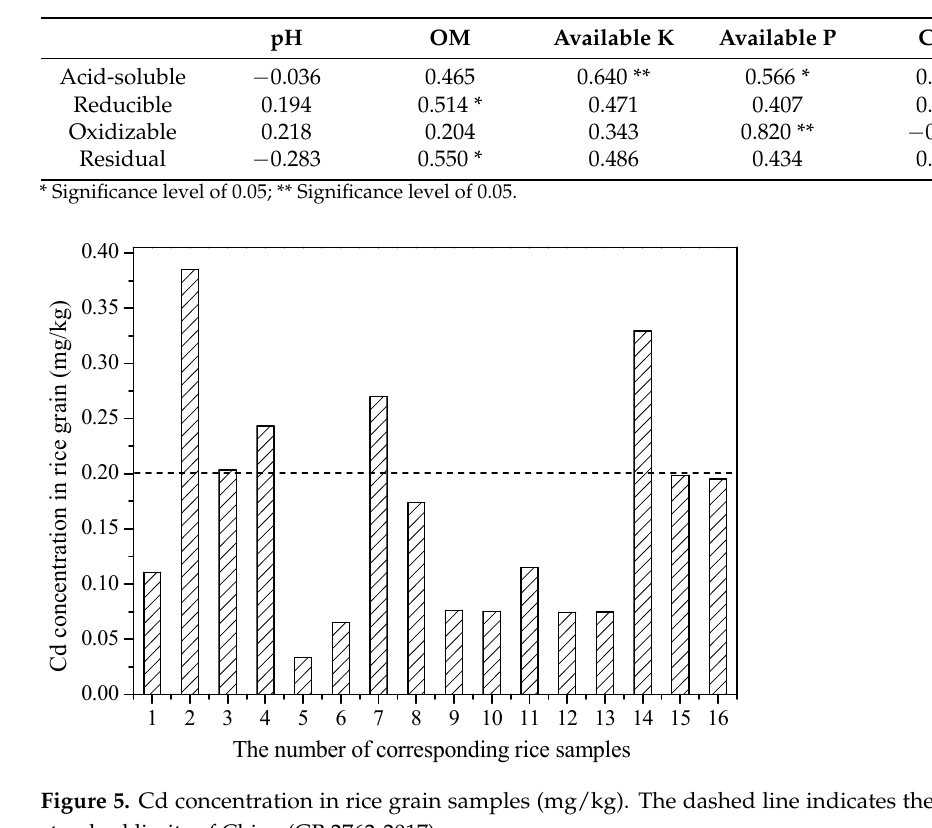
Figure 4. Fraction of Cd in these paddy soils. Table 3. Relationship between the Cd fractions and selected soil properties.